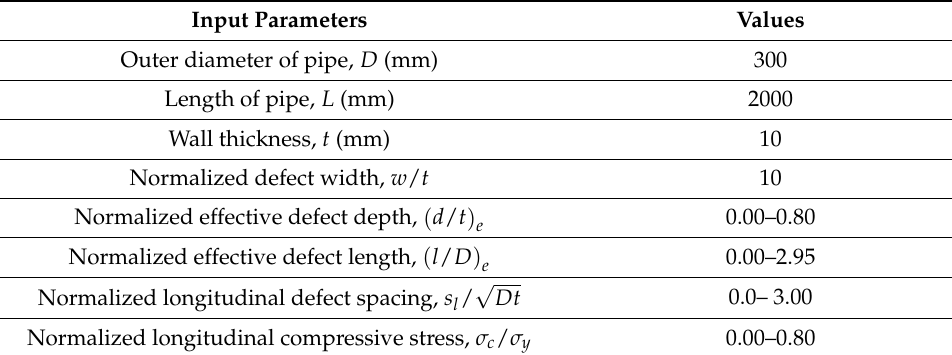
Table 4. Geometric parameters of the corroded pipe